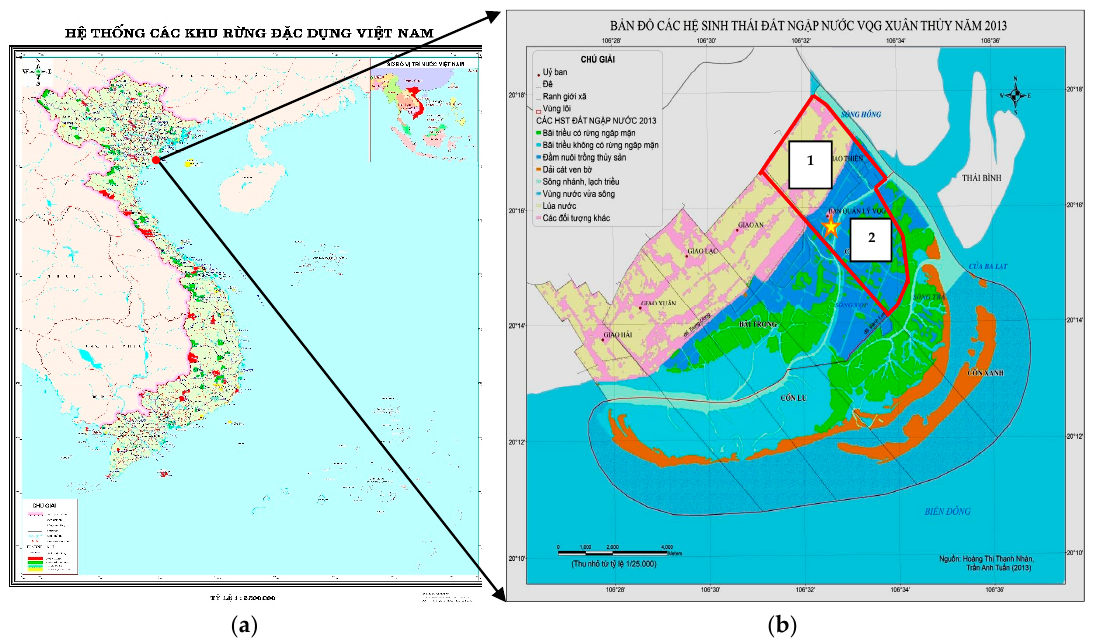
Figure 2. Description of the study site. ( a ) Map of protected areas in Vietnam; ( b ) The yellow area is surveyed rice farms (Number 1); the blue area is surveyed aquaculture farms (Number 2); the green area is mangrove trees; the yellow star signifies the XTNP (Xuan Thuy National Park) management board office. Overall, XTNP has six ecosystem typologies, including tidal wetland with mangroves (1661 ha),